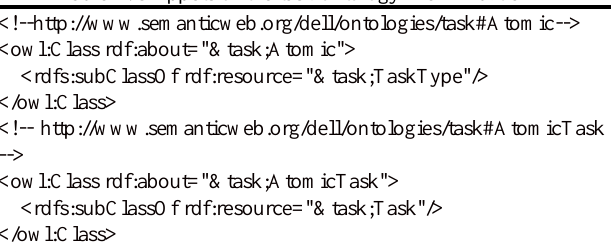
Table 1. Snippets of the task ontology file in